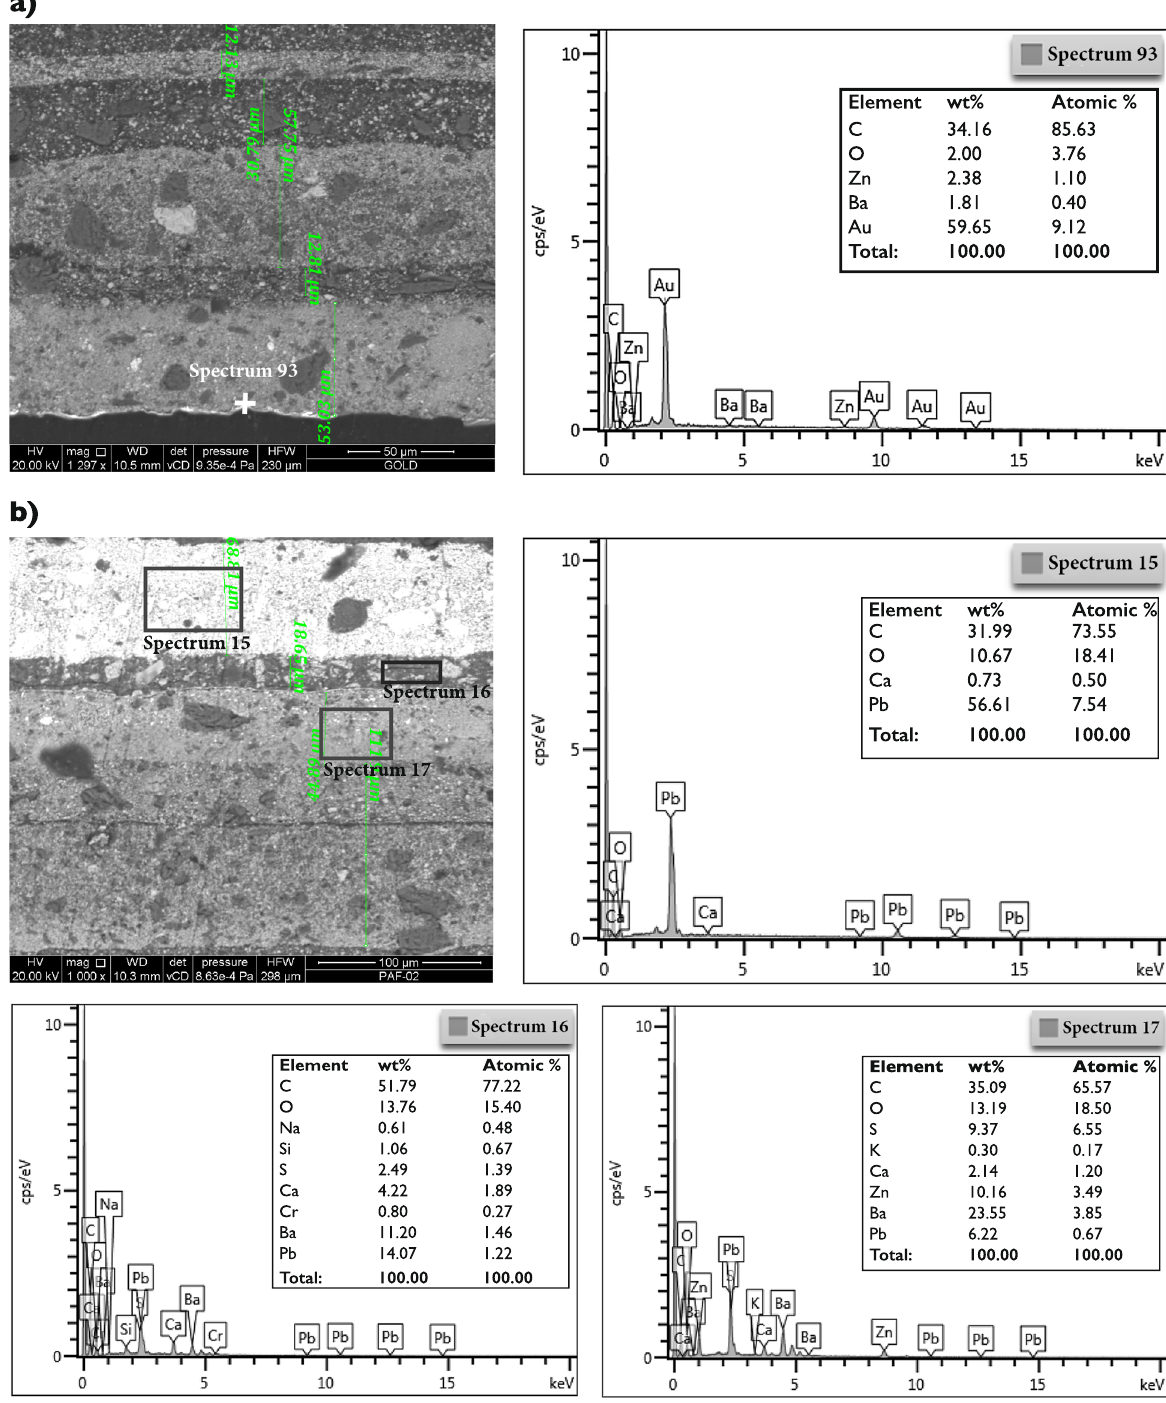
Fig. 11 a SEM micrograph of a section with gold leaf with corresponding EDS analysis showing gold. b SEM micrograph of a cross section with a red paint layer (red layers in the centre at spectrum 16 and 17) with corresponding EDS analysis showing lead in the white layer below the red layers. It should be noted that unlike common presentation of paint cross sections, both SEM images are inverted: the older layers appear uppermost, and so the gold ground appears above the gold leaf. Ba, S, Ca, and Zn in the red layers indicate filler materials. (Source: analysis of samples commissioned by Tongji Architectural Conservation Laboratory, analysed at the School of Chemistry of Xi’an Jiaotong University by Junyan